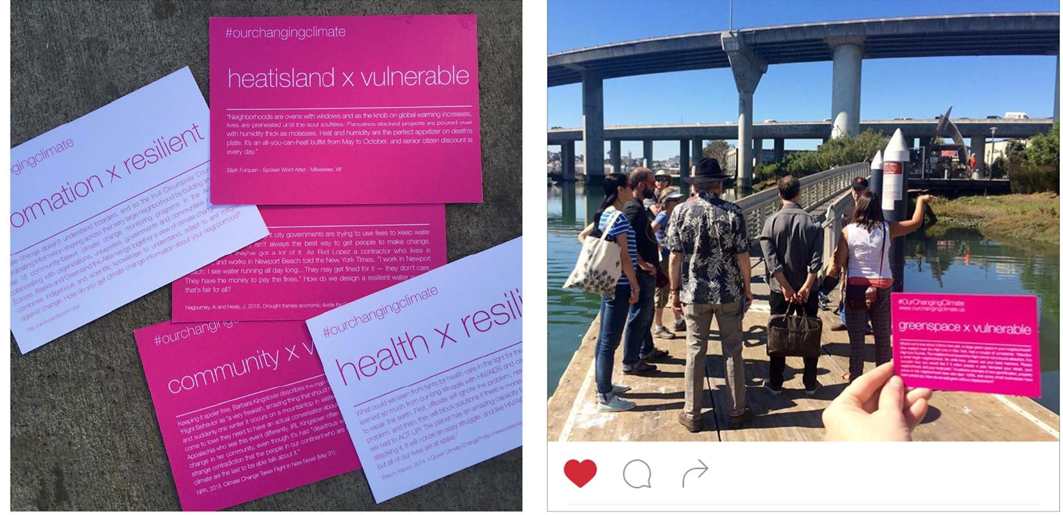
Figure 2. Thematic scavenger hunt